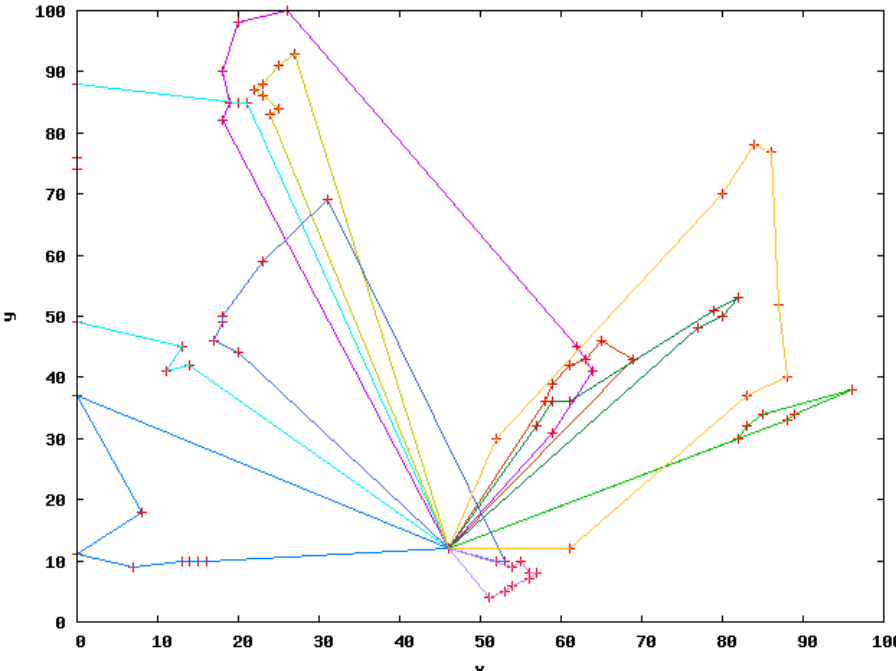
Figure 18. Best combinations, long, large instances experiment—example for largest Augerat set B, with fitness distance from the best-known one around